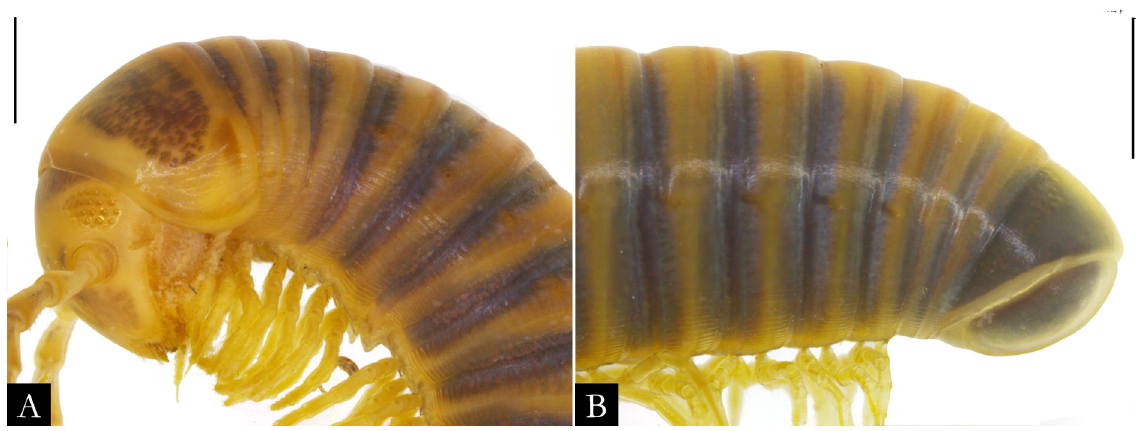
Fig. 123. Pseudonannolene segmentata Silvestri, 1895, ♂ (IBSP 1931), in lateral view. A . Anterior region. B . Posterior region. Scale bars = 1